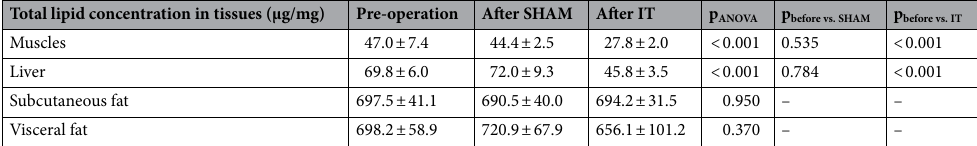
Table 5. Total lipids concentration in muscles, liver, subcutaneous and visceral fat of Zucker (Crl:ZUC(ORL)- Lepr fa ) rats before and 12 weeks after control (SHAM) or ileal transposition (IT) surgery. The results are presented as mean ± standard deviation. Significance for p-value was set at < 0.05.